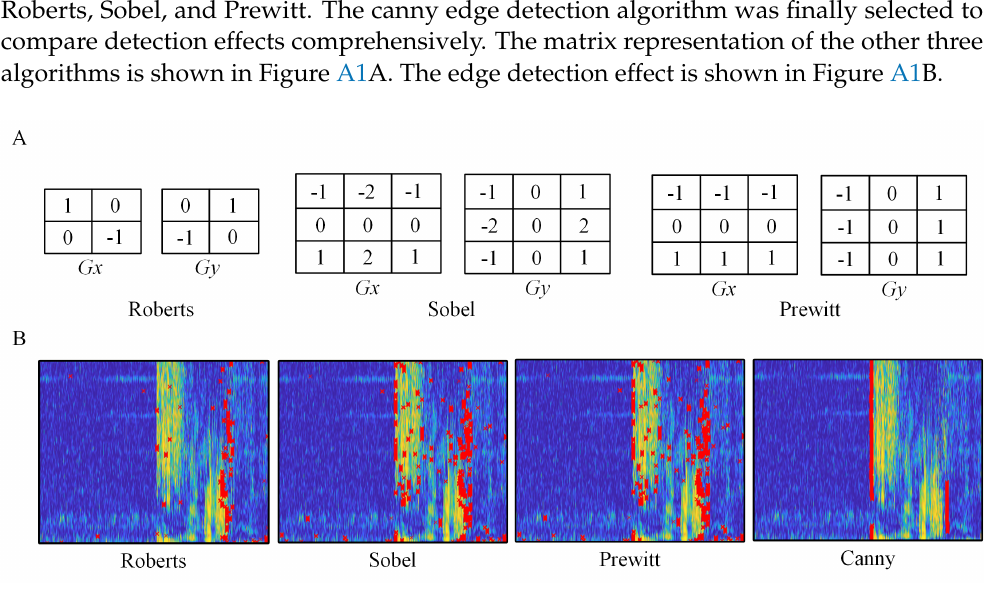
Figure A1. Comparison of detection effects of different edge detection algorithms. ( A ) The ma- trix representation of 3 algorithms: Roberts algorithm, Sobel algorithm, and Prewitt algorithm. ( B ) Comparison of edge detection effects of 4